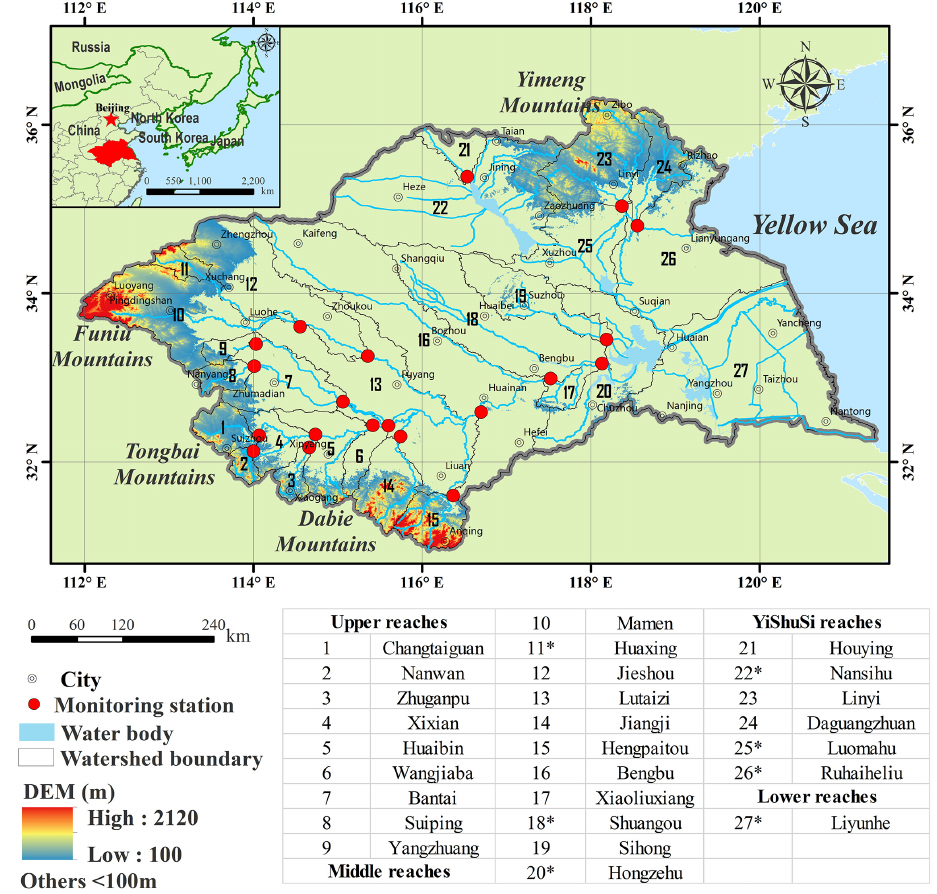
Figure 1. The boundaries of the 27 watersheds used in constructing N budgets. We did not have sufficient monitoring data for watersheds 11, 18, 20, 22, 25, 26, and 27 (labeled with an asterisk). The following AN flux analysis does not include these seven